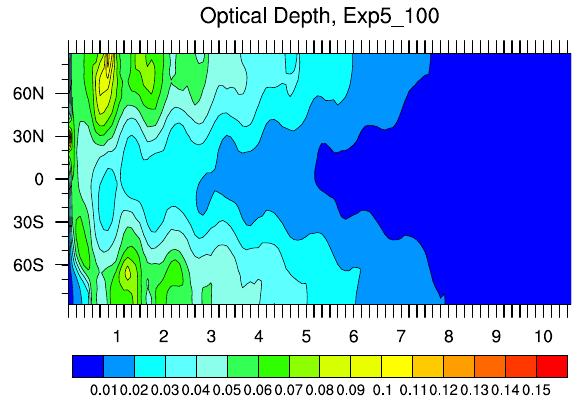
Fig. 3. Visible optical depth of soot particles for the Exp5_100 case as a function of latitude and